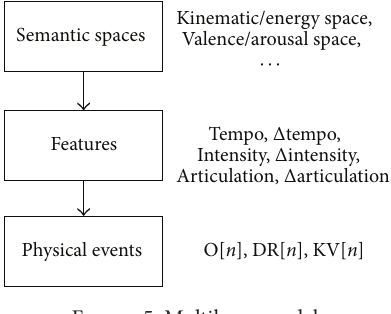
Figure 5: Multilayer